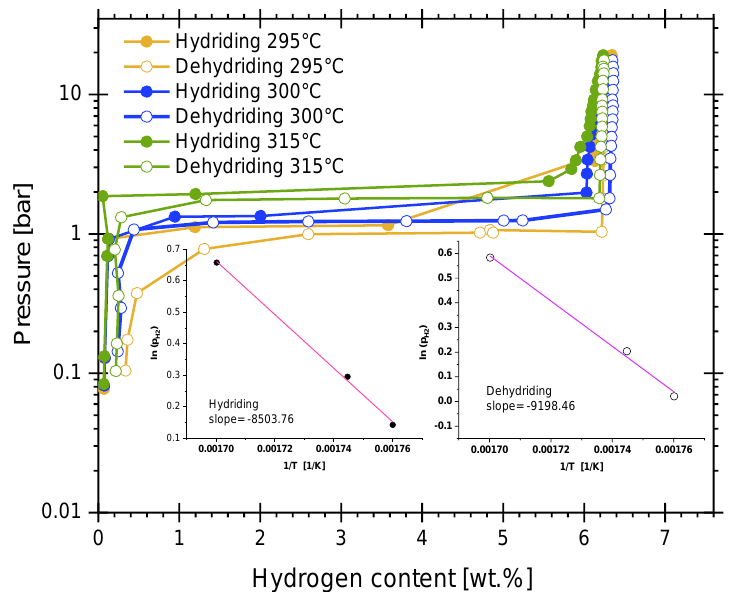
Figure 5. PCI experiments at different temperatures of cryogenically prepared Mg-15wt.% VCl 3 (shown in absolute pressure). Insets: hydriding and dehydriding equilibrium pressures versus 1/T for estimation of the hydriding and dehydriding enthalpies and entropies.